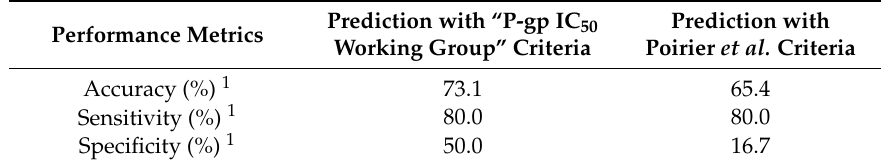
Table 4. Accuracy, sensitivity, and specificity of the prediction of clinical P-gp interactions with IC 50 values generated from rhodamine 123 accumulation assays according to “P-gp IC 50 working group” [42] or Poirier et al. [41]